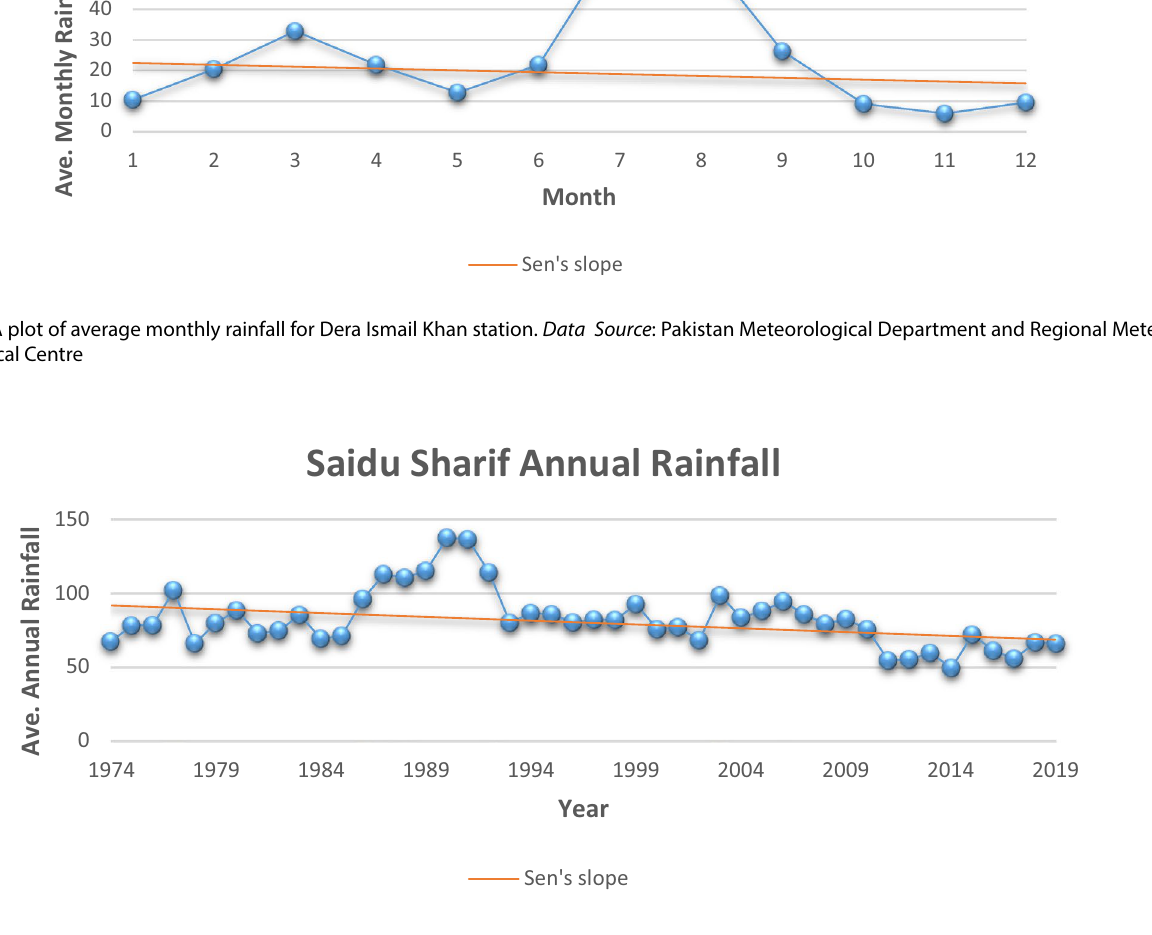
Fig. 6 A plot of average annual rainfall for Saidu Sharif station. Data Source : Pakistan Meteorological Department and Regional Meteoro- logical